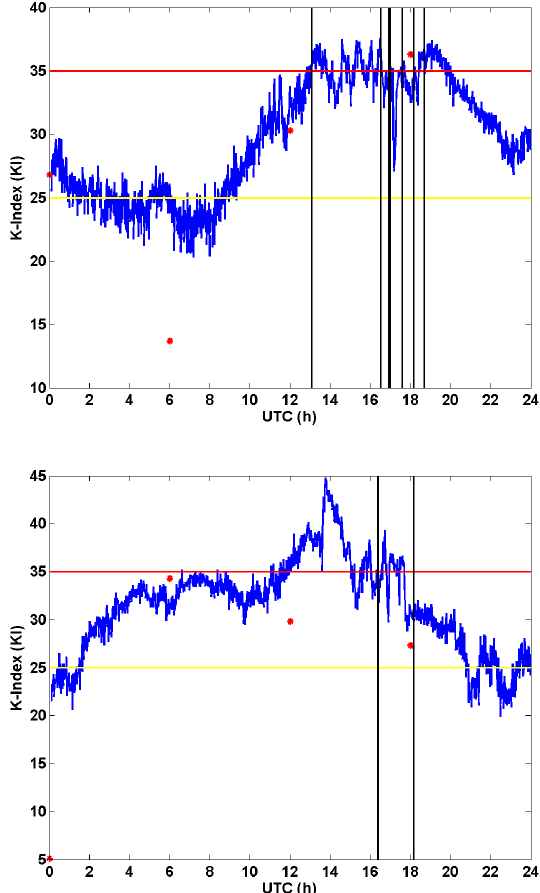
Figure 2. Top: 24h time series of K index computed from MWRP NNz retrievals (blue line), and radiosonde profiles (red dots) for 12 August 2010. Thunder near Lindenberg started at 13:05 and lasted until 18:40UTC; vertical black lines indicate the time of thunder detection. Yellow and red lines show the boundaries for weak-to-moderate and moderate-to-strong thunderstorm potential thresholds, respectively. Bottom: case of 15 August 2010. Thunder near Lindenberg was reported between 16:10 and